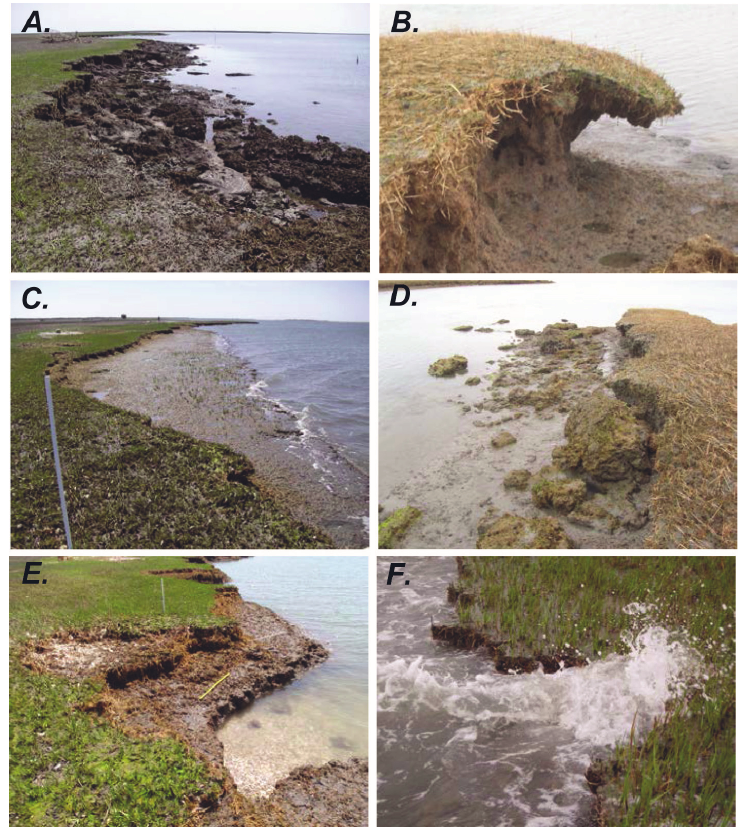
Figure 1. Degradation of marsh scarps in Hog Island Bay, Virginia. The action of waves at lower water levels can remove previously eroded material ( A ) and cause undercutting ( B ); The process of root scalping occurs when waves attack the marsh at water levels approaching the marsh platform elevation ( C ); toppling is also common ( D ); Examples of wave gully: at low tide ( E ) and during a storm with wave energy concentration ( F